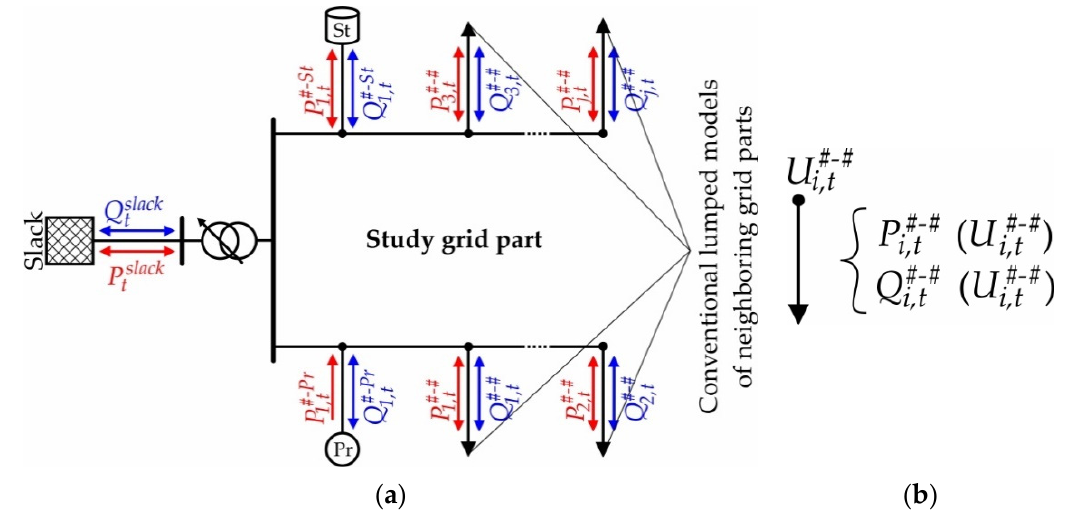
Figure 2. Overview of the conventional power system modeling: ( a ) detailed model of study grid part; ( b ) lumped grid model.